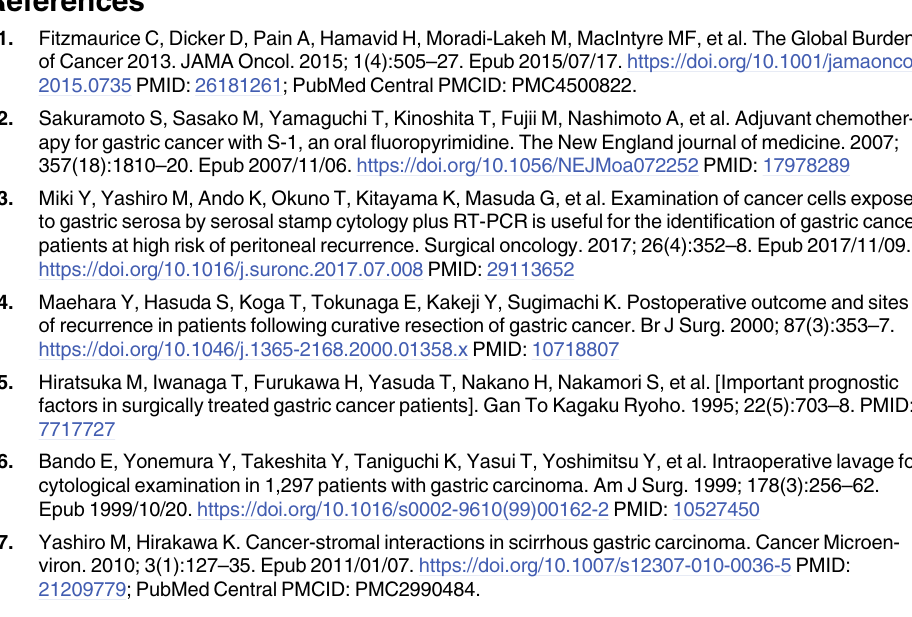
S1 Table. Correlation between peritoneal recurrence and clinicopathologic features in 96 gastric cancer cases at T3 stage. S2 Table. Correlation between DIFS � 234 and lymph node